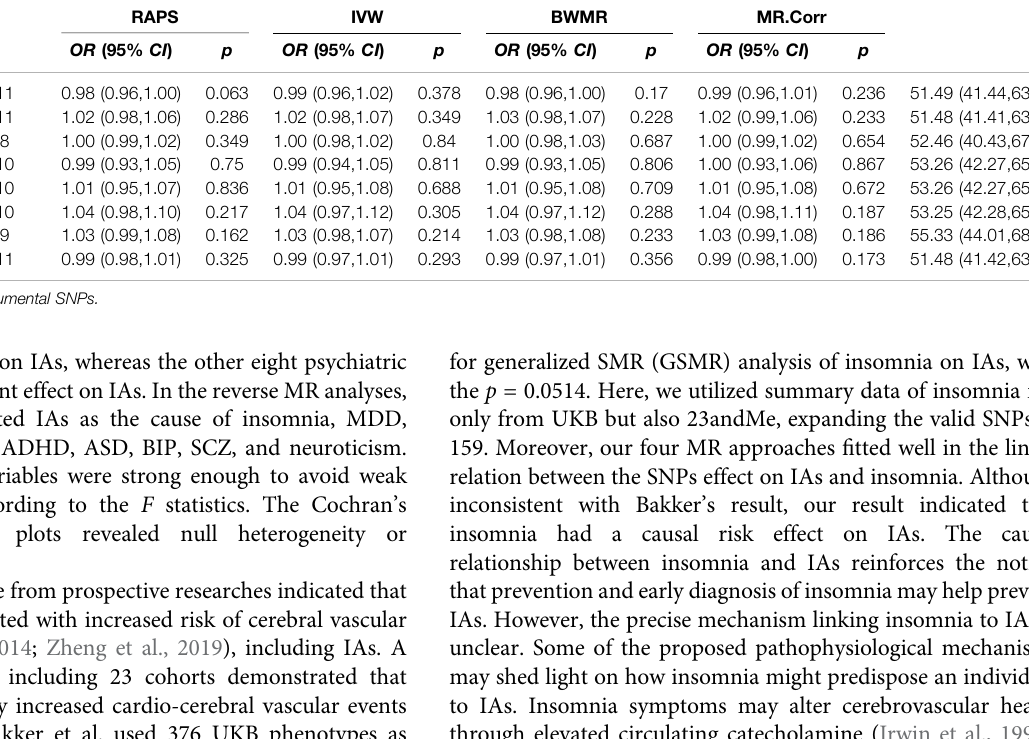
TABLE 3 | The casual effects of IAs on the eight psychiatric traits by two-sample MR analyses. Outcome N